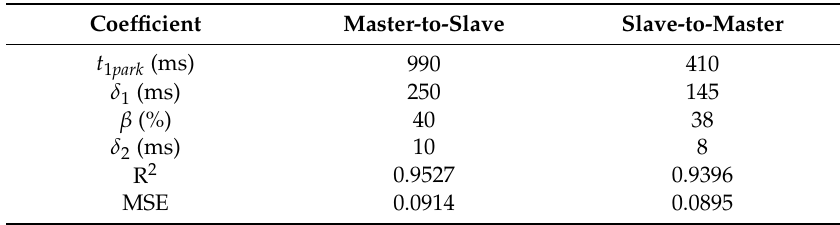
Table 1. Values of the coefficients in Equation (1) for master-to-slave and slave-to-master multi-hop communication with nodes in park